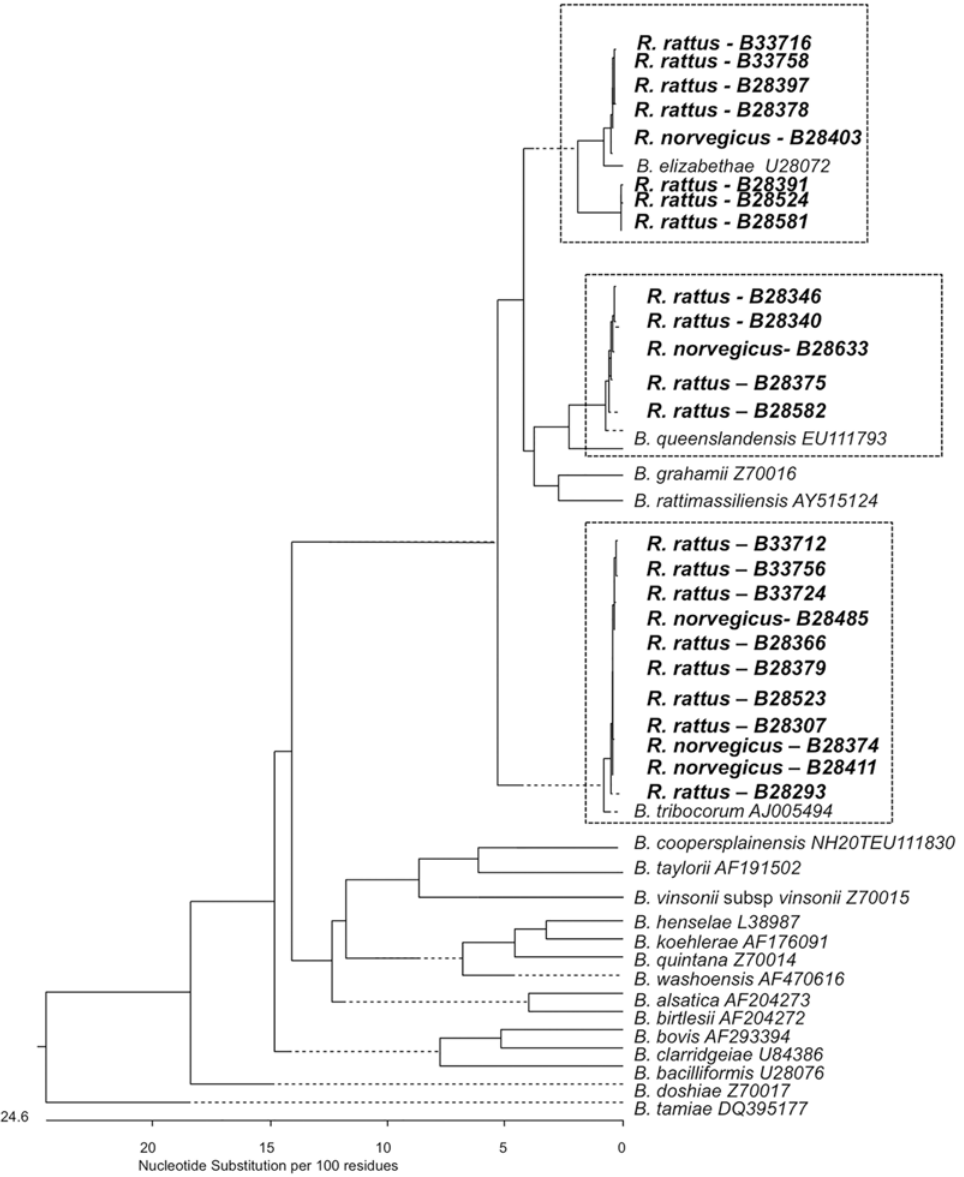
Fig 4. Phylogenetic tree of Kibera Bartonella isolates. Phylogenetic tree of Bartonella isolates obtained from Kibera rodents (shown in bold) and previously described reference strains for globally dispersed Bartonella species based on sequence analysis of the citrate synthase ( gltA ) gene. The phylogenetic tree was constructing using the neighbor-joining method. Dotted lines indicate negative branch